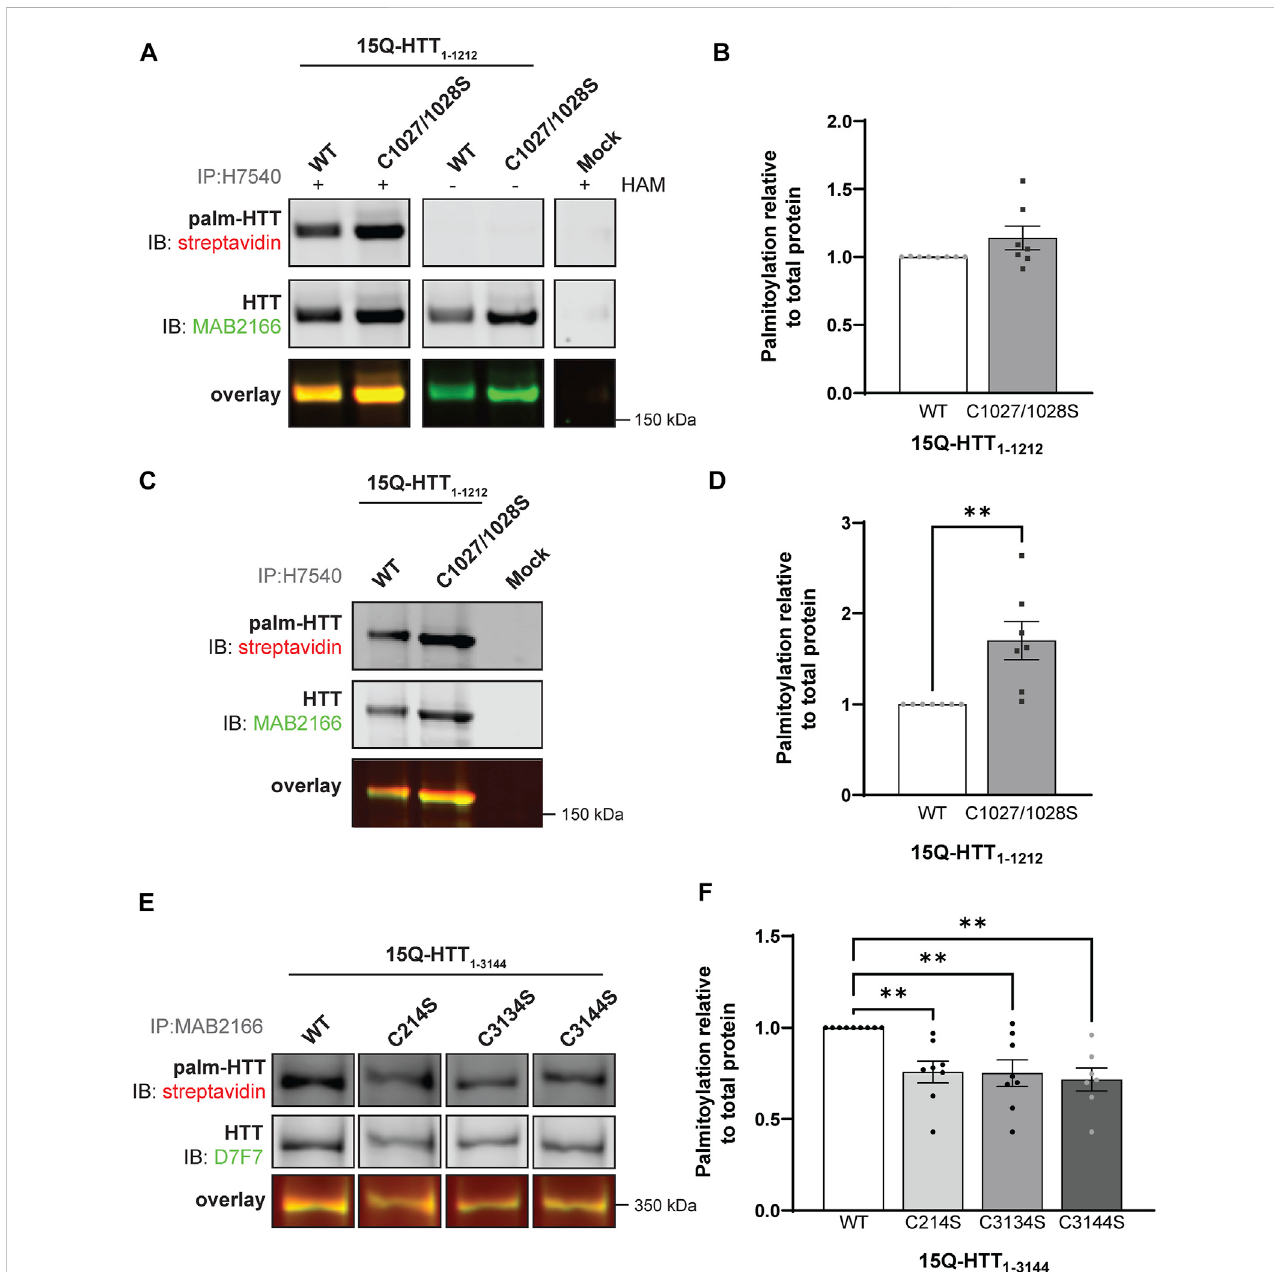
FIGURE 3 Huntingtin is palmitoylated at cysteines 3134 and 3144. (A) COS-7 cells transiently expressing 15Q-HTT 1-1212 WT or carrying two cysteine-to-serine mutations at residues 1027 and 1028 (C1027/1028S) were harvested 48 h post-transfection, and subjected to the IP-ABE assay. Proteins were immunoprecipitatedfromlysatesusingN-terminalHTTantibodies(H7540).PalmitoylatedHTTlabeledwithbiotinwasdetectedbywesternblotanalysisusing streptavidin,andtotalHTTwithMAB2166antibodies.Thepalmitoylationsignal(palm-HTT,HAM+)andthenegativecontroltreatment(HAM-)areshown in the top panels, the total HTT protein immunoprecipitated is presented in the corresponding middle panels, and the overlay of the two is displayed in the bottom panels. Uncropped blots are displayed in Supplementary Figure S5, (B) HTT palmitoylation level was calculated as the ratio of palmitoylated HTT over totalHTT proteinsignal, and represented relativeto 15Q-HTT 1-1212 WT (n= 7), (C) COS-7cells transiently expressing 15Q-HTT 1-1212 WT or C1027/1028S were labeled with alkyne-palmitate for 6 h, and harvested 48 hpost-transfection. Proteins were immunoprecipitated from lysates with H7540antibodies,and bio- orthogonallylabeledwithazido-biotinbyclickchemistry.PalmitoylatedHTT 1-1212 (toppanel)labeledwithbiotinwasdetectedwithstreptavidin,andtotalHTT (corresponding middle panels) was detected with HTT antibodies (MAB2166). The overlay of the two is displayed in the bottom panels. Uncropped blots are displayed in Supplementary Figure S5, (D) HTT palmitoylation level was calculated as the ratio of palmitoylated HTT over total HTT protein signal, and represented relative to 15Q-HTT 1-1212 WT (n = 7), (E) HeLa cells transiently expressing 15Q-HTT 1-3144 WT, C214S, C3134S and C3144S were labeled with alkyne-palmitate for 6 h, and harvested 48 h post-transfection. Proteins were immunoprecipitated from lysates with HTT (MAB2166) antibodies, and bio- orthogonallylabeledwithazido-biotinbyclickchemistry.PalmitoylatedHTT 1-3144 (toppanel)labeledwithbiotinwasdetectedwithstreptavidin,andtotalHTT (correspondingmiddlepanels)wasdetectedwithHTTantibodies(D7F7).Theoverlayofthetwoisdisplayedinthebottompanels.Thewesternblotimagesare composites of different lanes from the same image (Supplementary Figure S6), (F) HTT palmitoylation level was calculated as the ratio of palmitoylated HTT overtotalHTTproteinsignal,andrepresentedrelativeto15Q-HTT 1-3144 WT(n=7 – 8). Statisticalanalysis : (B) Unpaired t -test: p =.11. (C) Unpaired t -test:** p = .0058. (F) 1-wayANOVA:CtoSmutations,** p =.0024.Bonferroni ’ smultiplecomparisonstest:WTvs.C214S,** p =.0090;WTvs.C3134S,** p =.0073;WTvs. C3144S, ** p =